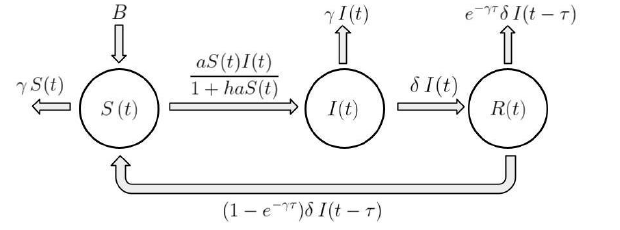
Figure 1. Graphical scheme of the risk contagion